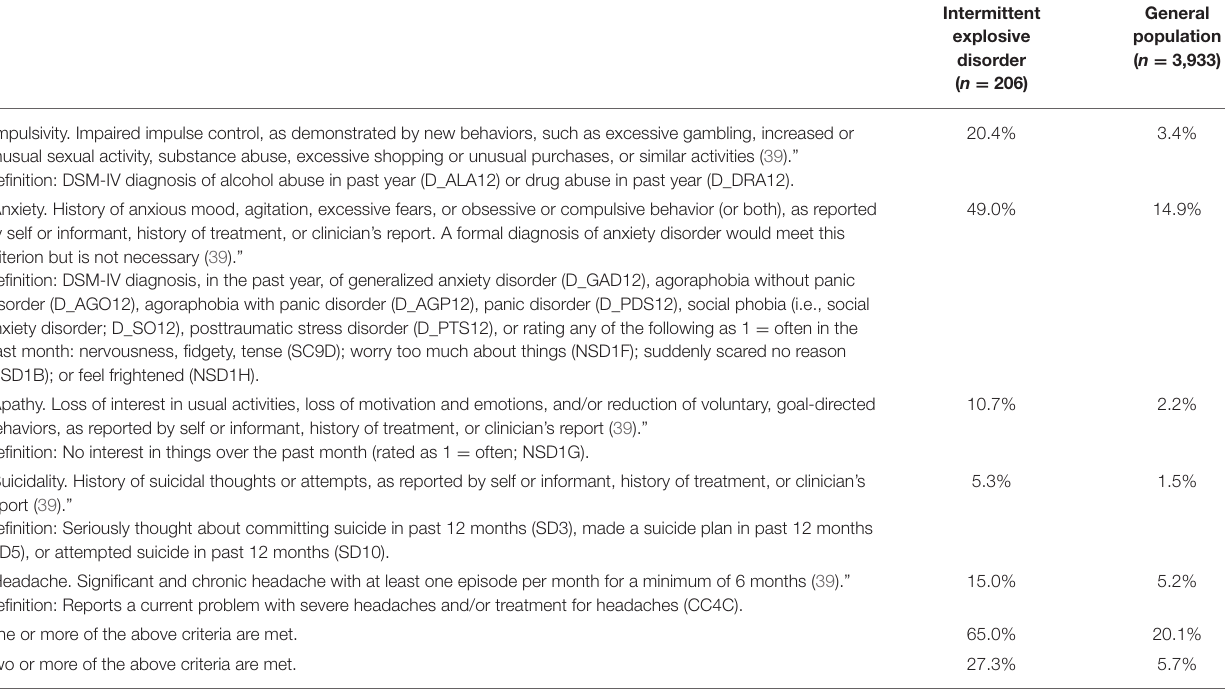
TABLE 3 | Percentage of men meeting research criteria for supportive features of traumatic encephalopathy